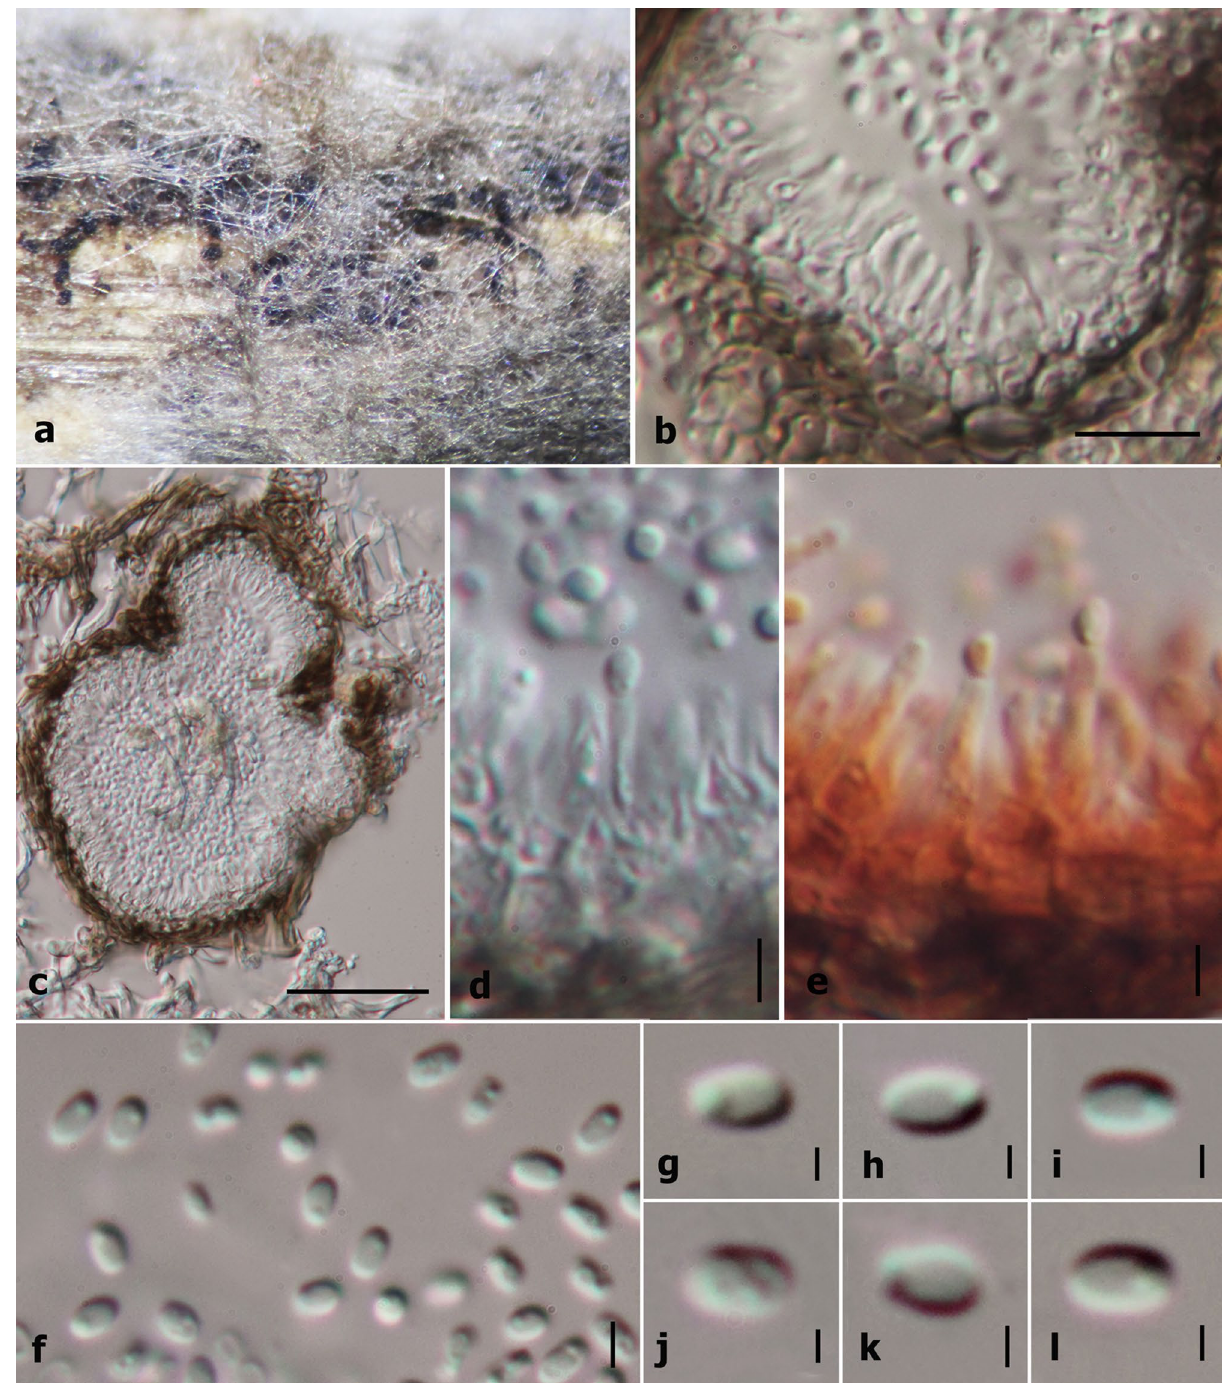
Figure 4. Asexual morph characters of Sublophiostoma thailandica MFLU 11–0158. ( a ) Conidiomata on bamboo pieces on WA after 8 weeks. ( b ) Conidioma wall. ( c ) Section of conidioma. ( d) Conidiogenous cells. (e ) Conidiogenous cells stained in congo red. ( f–l ) Conidia. Scale bars: b = 10 µm, c = 50 µm, d, e, f = 2 µm, g–l = 1